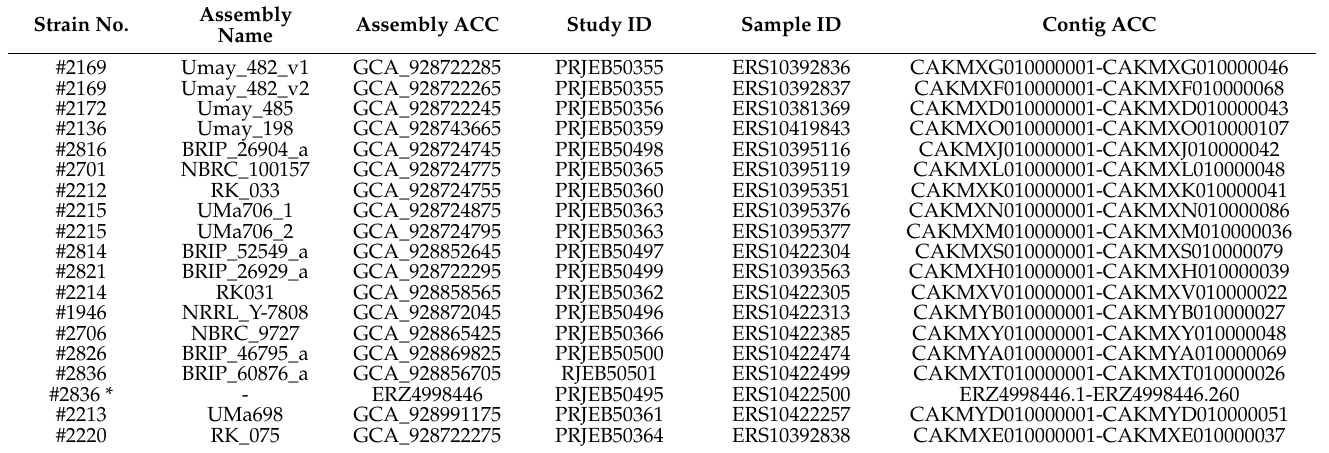
Table 1. DDBJ/EMBL/GenBank database accession